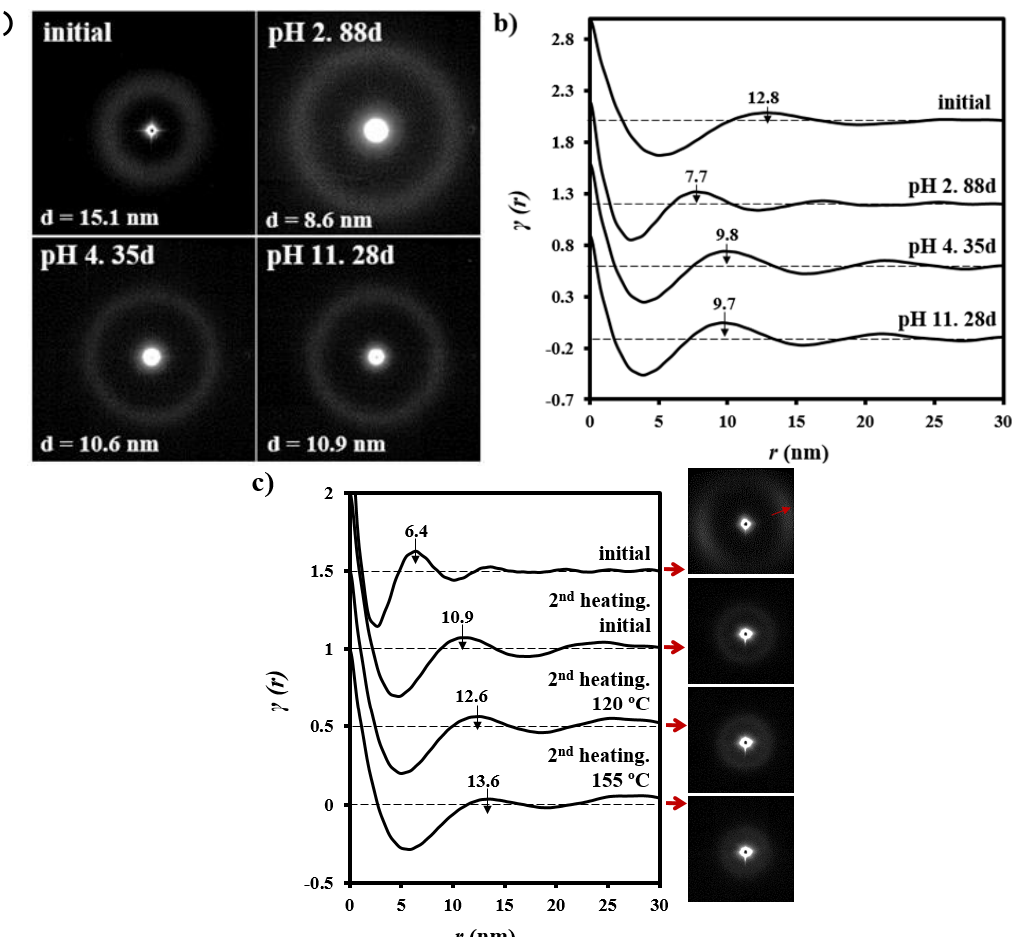
Figure 16. SAXS patterns ( a ) and corresponding correlation functions ( b ) at the end of a cooling run performed at 10 °C/min from the melt state of γ irradiated GL- b -[GL- co -TMC- co -CL]- b -GL samples before and after being degraded at pH 4 for 35 days, pH 11 for 28 days and pH 2 for 88 days. ( c ) SAXS patterns and correlation functions of a γ irradiated GL- b -[GL- co -TMC- co -CL]- b -GL sample degraded at pH 9 for 35 days that were obtained from sample directly extracted from the degradation medium and at different temperatures during a second heating run performed at 10 °C/min. Red arrows indicate the fiber